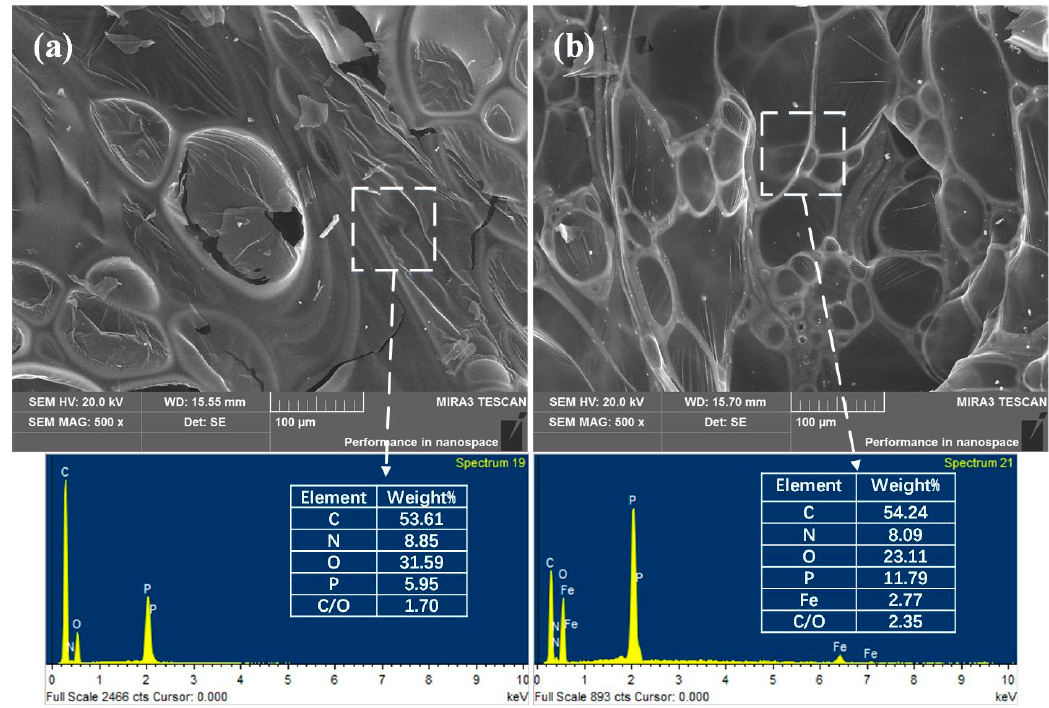
Figure 10. SEM image of EP/15MAPP ( a ) and EP/15PPy-MAPP ( b ) after cone calorimetry test.